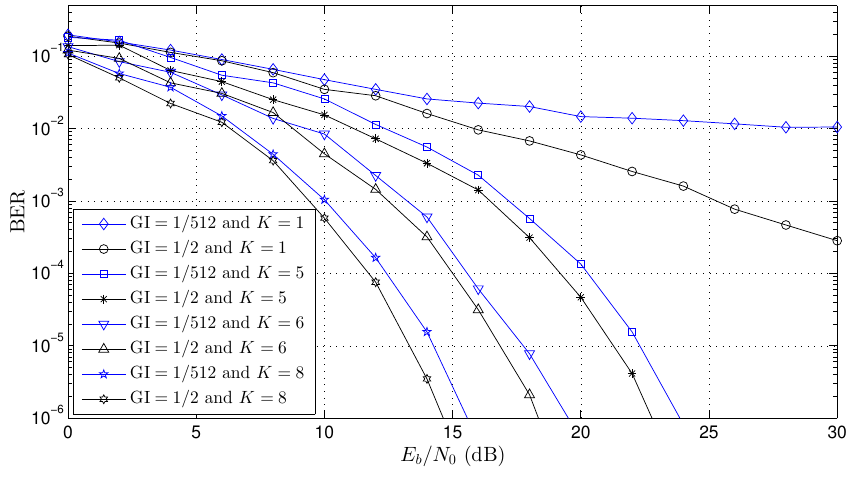
Figure 6. BER performance curve for Channel 1 (see Table 3).